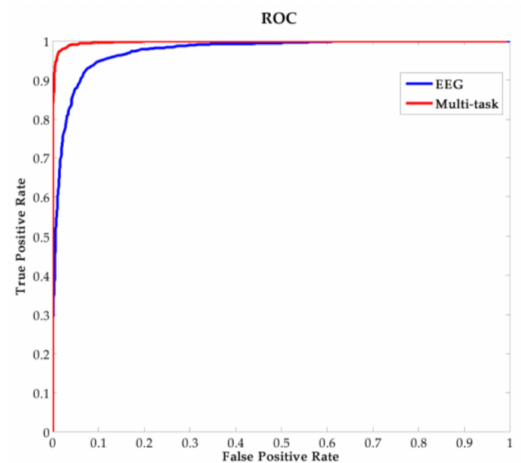
Figure 14. The average ROC curves of EEG-based and multi-task authentication system.